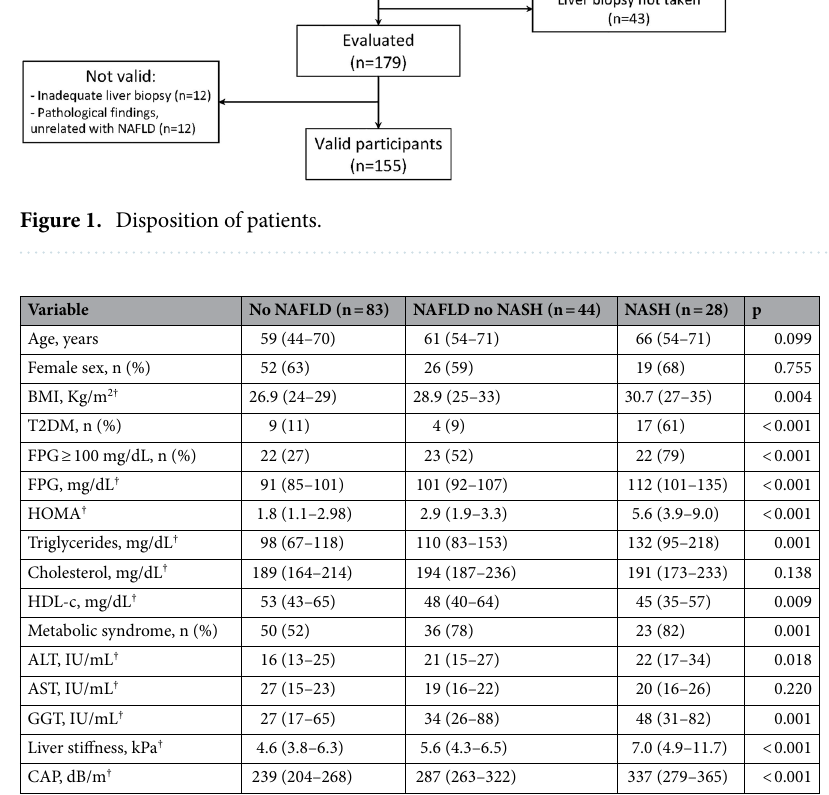
Table 2. Variables associated with the SAF category: No NAFLD, NAFLD without NASH and NASH (n = 155). CAP controlled attenuation parameter, BMI Body mass index, HDL-c HDL-cholesterol, HOMA homeostasis model assessment, FPG Fasting plasma glucose, T2DM type 2 diabetes mellitus. † Median (Q1-